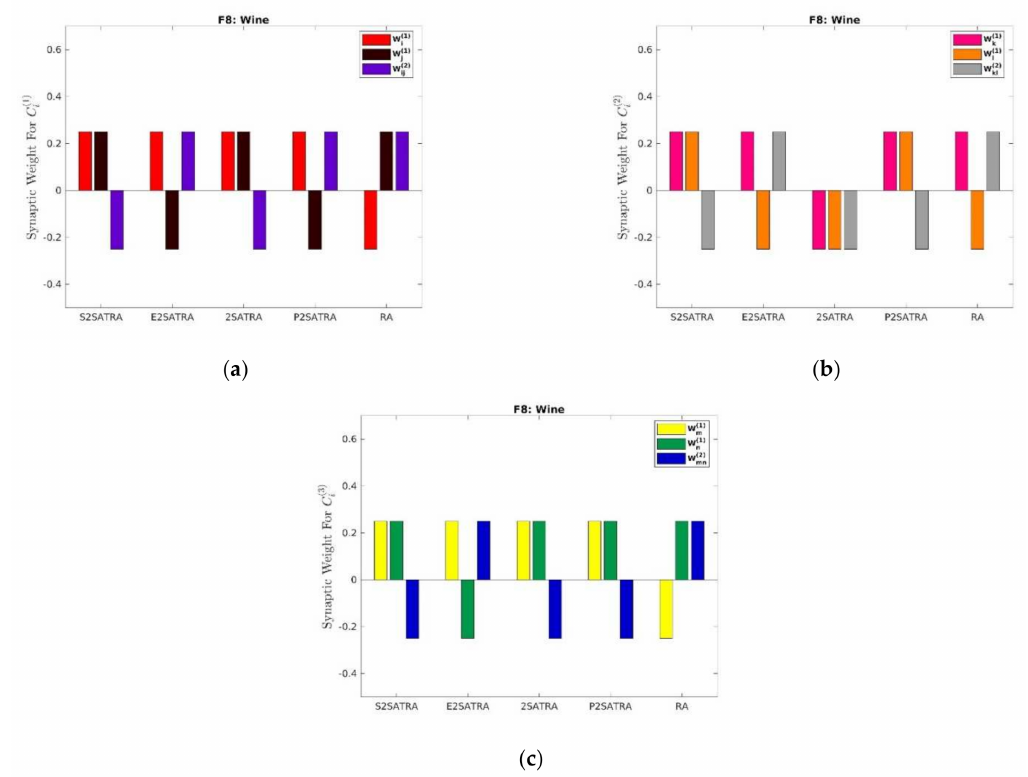
( 1 ) ( 2 ) ; ( b ) C and ( c ) C i i